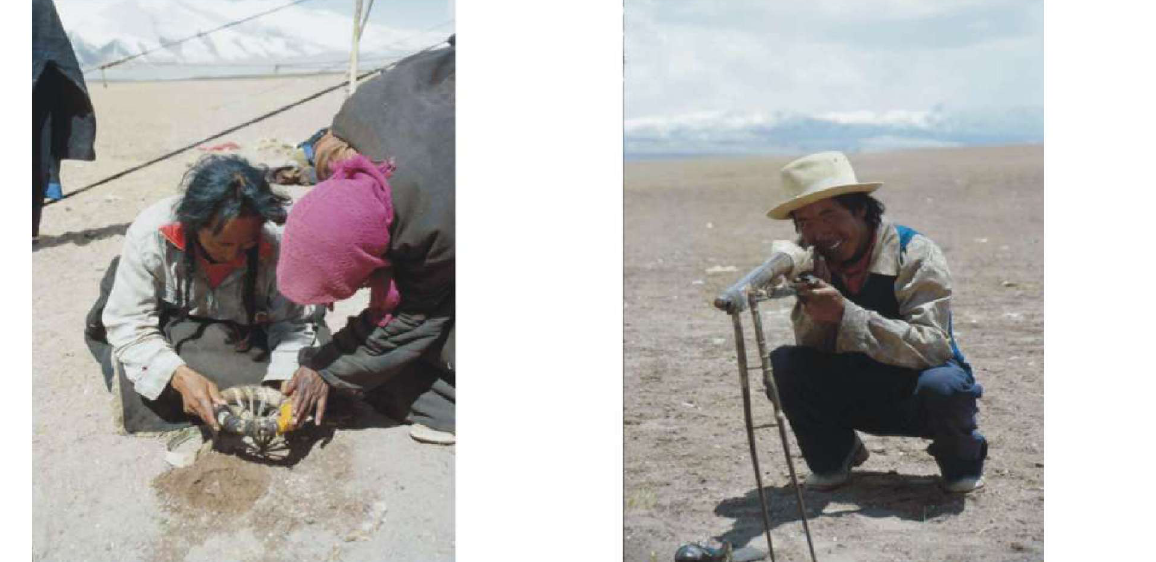
Fig. 2. Aru basin nomads demonstrating how to use a traditional leg-hold chiru trap, and an old Tibetan flintlock rifle.